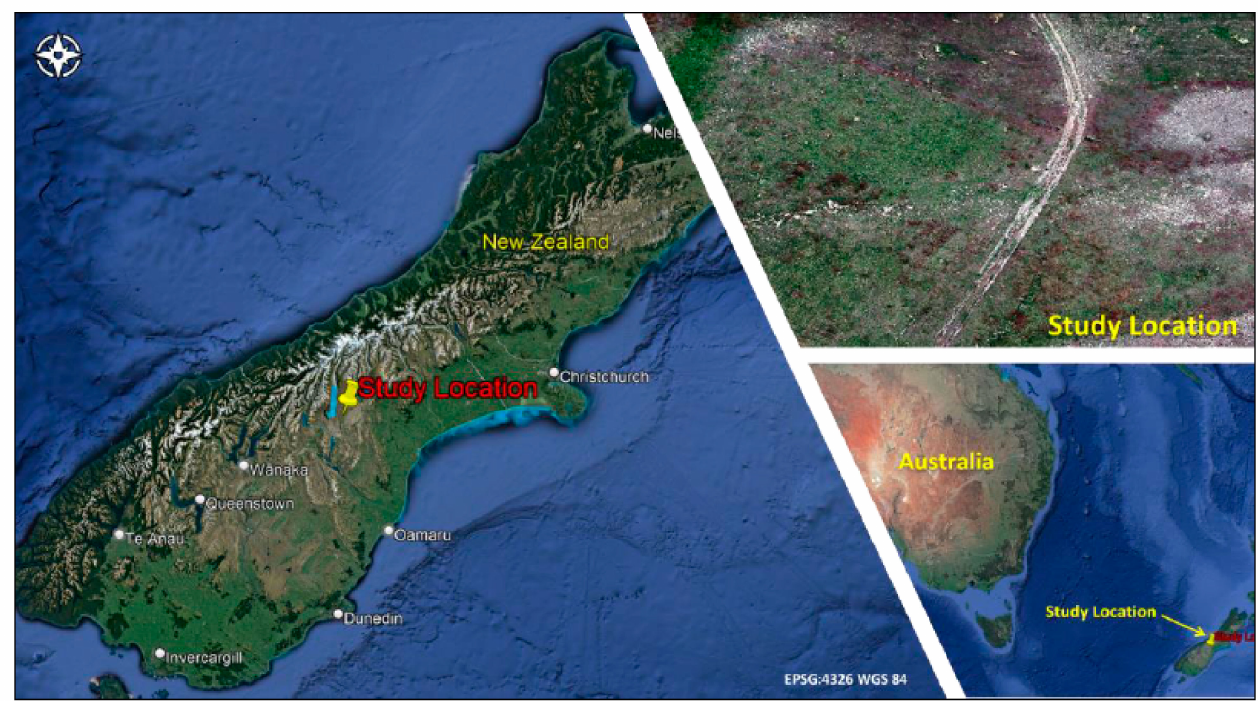
Figure 1. Study site location at Sawdon Station, New Zealand (EPSG:4326—WGS 84).